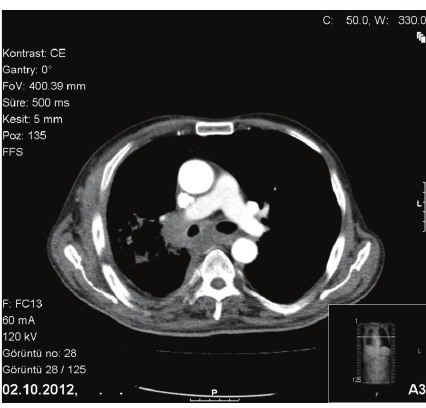
Figure 1: Subcarinal and right hilar lymphadenopathies in thorax CT.